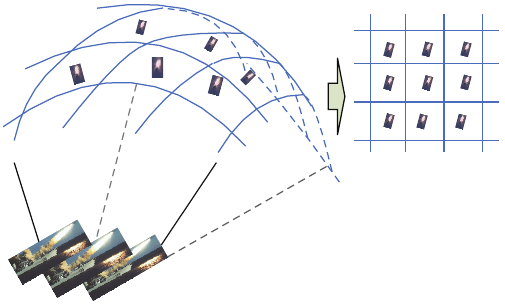
Figure 2: Air defense of a naval group.